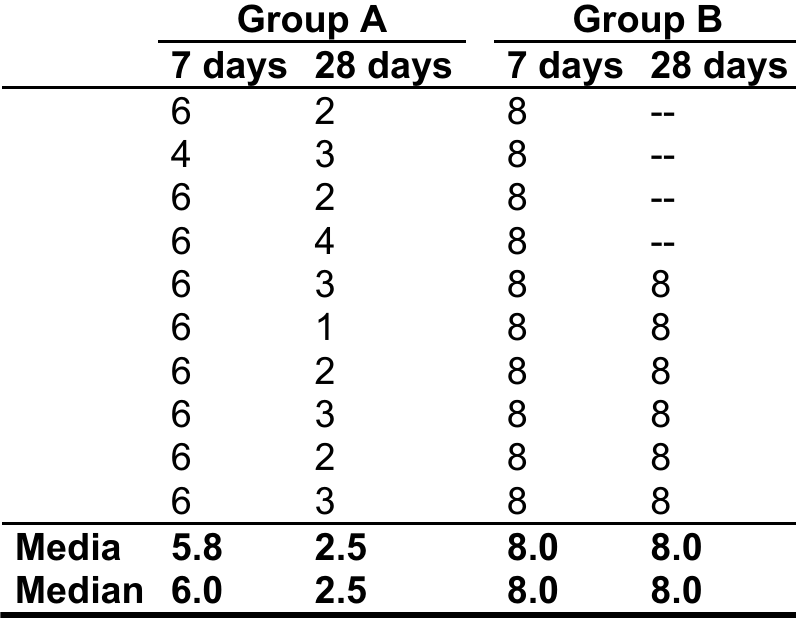
TABLE 1 - Rats subjected to implant according to the values of deformation of the implant